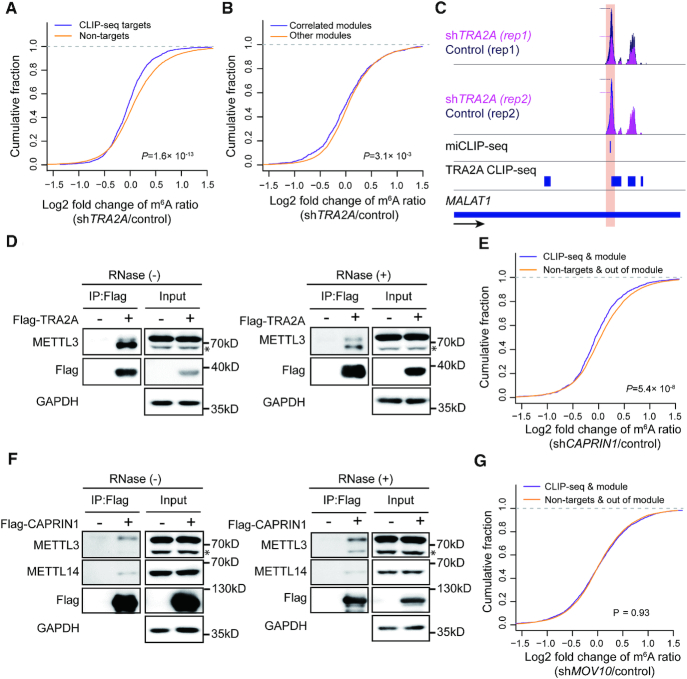
Experimental validation of selected m6A regulators. (A) Plot of cumulative fraction of log2 fold change of m6A ratios upon TRA2A knockdown for the m6A peaks overlap or non-overlap with TRA2A CLIP-seq targets. P-value of two-tailed Wilcoxon test is indicated. (B) Plot of cumulative fraction of log2 fold change of m6A ratios upon TRA2A knockdown for the m6A peaks within or not within the co-methylation modules correlated with TRA2A. P value of two-tailed Wilcoxon test is indicated. (C) Tracks displaying the read coverage of IPs normalized by inputs as well as the miCLIP-seq m6A sites and TRA2A CLIP-seq peaks in HepG2 cells on the long non-coding gene MALAT1. The m6A peak with down-regulated m6A ratio in shTRA2A is highlighted. The dashed lines indicate the summits of the peaks. (D) Western blots showing the interaction between TRA2A and METTL3 with and without RNase treatment respectively. * indicates a non-specific band (see Supplementary Figure S5B). (E) Plot of cumulative fraction of log2 fold change of m6A ratios upon CAPRIN1 knockdown comparing the m6A peaks in the correlated modules and overlap with CAPRIN1 CLIP-seq targets versus the peaks not within the correlated module or overlap with CAPRIN1 CLIP-seq targets. P-value of two-tailed Wilcoxon test is indicated. (F) Western blots showing the interactions of CAPRIN1 with METTL3 and METTL14 with and without RNase treatment respectively. * indicates a non-specific band (see Supplementary Figure S5B). (G) Plot of cumulative fraction of log2 fold change of m6A ratios upon MOV10 knockdown comparing the m6A peaks in the correlated modules and overlap with MOV10 CLIP-seq targets versus the peaks not within the correlated module or overlap with MOV10 CLIP-seq targets. P-value of two-tailed Wilcoxon test is indicated.